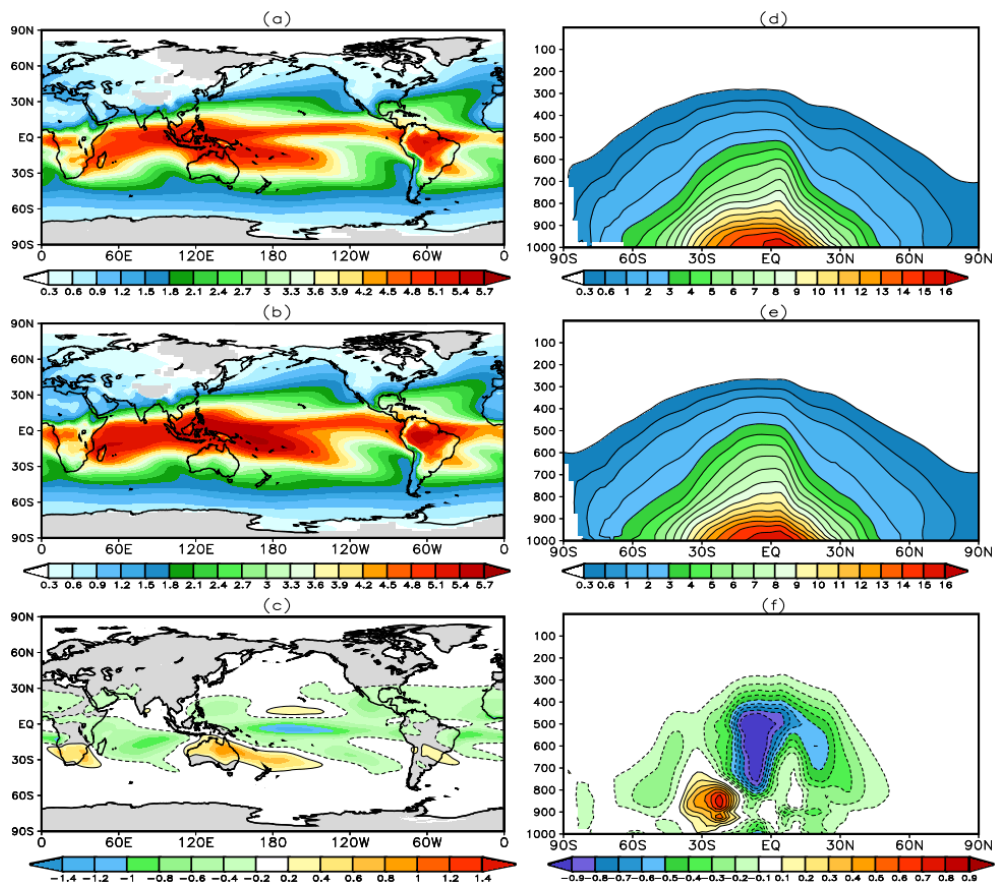
Figure 11. (a) December-January-February total precipitable water in millimeters from experiment 6 (MERRA AGCM-like), (b) same as (a) but from experiment 5, (c) same as (a) but the difference of experiment 6 minus experiment 5, (d) December-January-February-specific humidity in gkg − 1 from experiment 6 (MERRA AGCM-like), (e) same as (d) but from experiment 5, (f) same as (d) but the difference of experiment 6 minus experiment